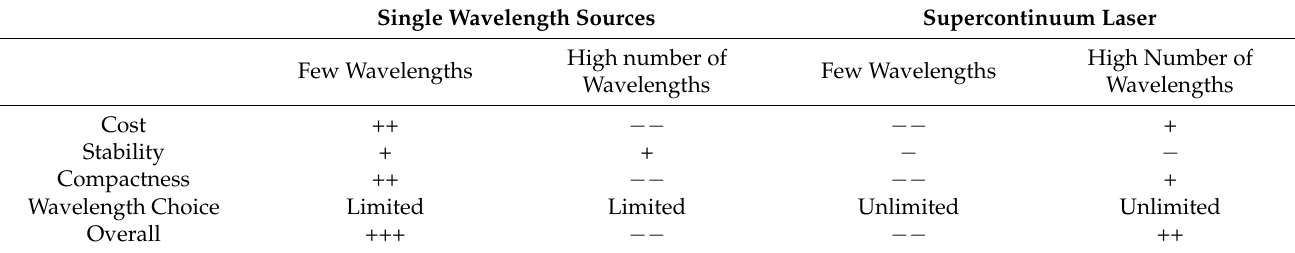
Table 3. Main relative advantages and drawbacks of single wavelength laser diode sources and SCL as function as the number of wavelengths used for TD systems. (+ advantages / − disadvantages). FW: Few Wavelength, HNW: High number of